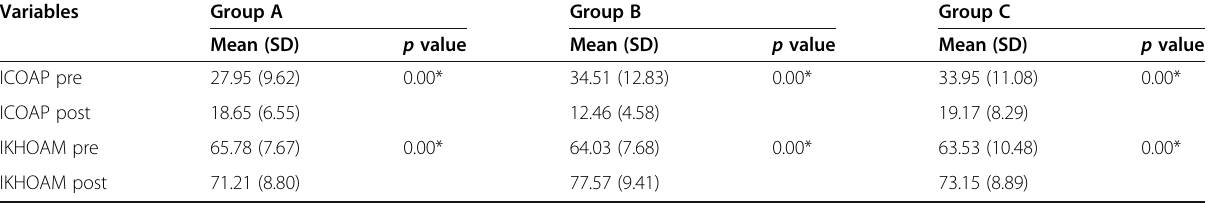
Table 2 Intragroup analysis for pain and functional disability using Wilcoxon signed ranks test